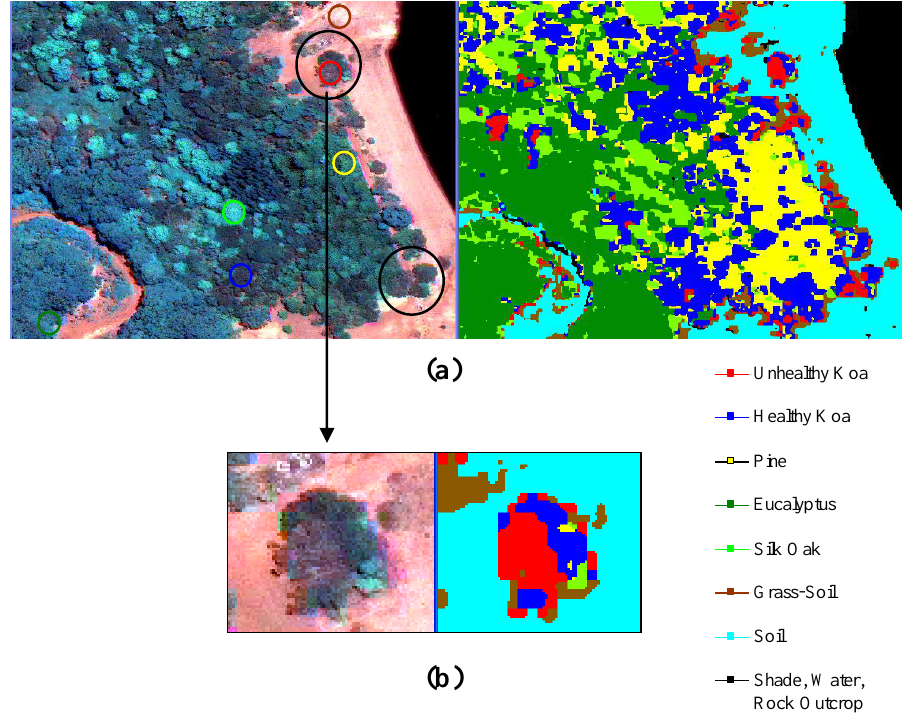
Figure 5. Close up of a natural color composite (left) showing the location of geo-located testing sites (colored circles) for comparison with resulting classes in the classified image (right). Circle colors match class colors in the classified image. Black circles in the color composite represent areas containing a mixture of unhealthy (brown) and healthy koa (green) stands.